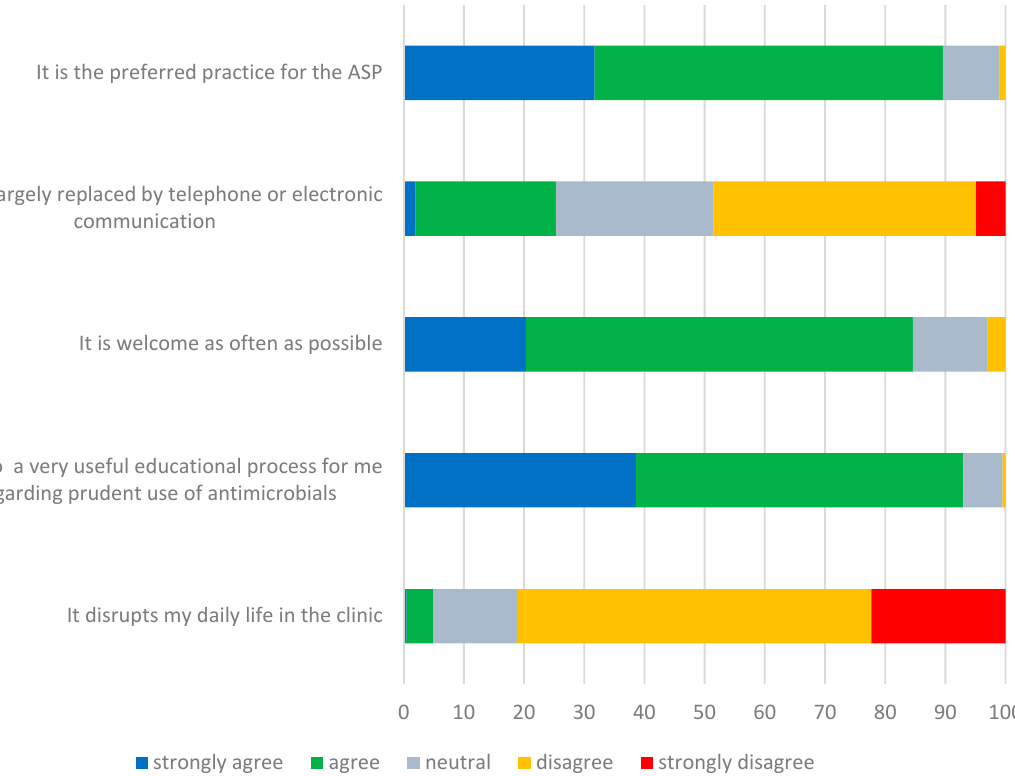
Figure 2. Respondents’ perceptions regarding in-person consultation as the followed practice for our hospital’s ASP.